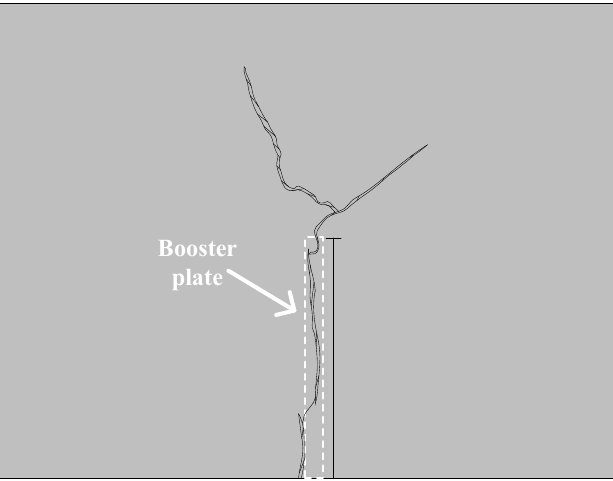
Figure 16. Schematic view of the connected cracks during the crack propagating stage.